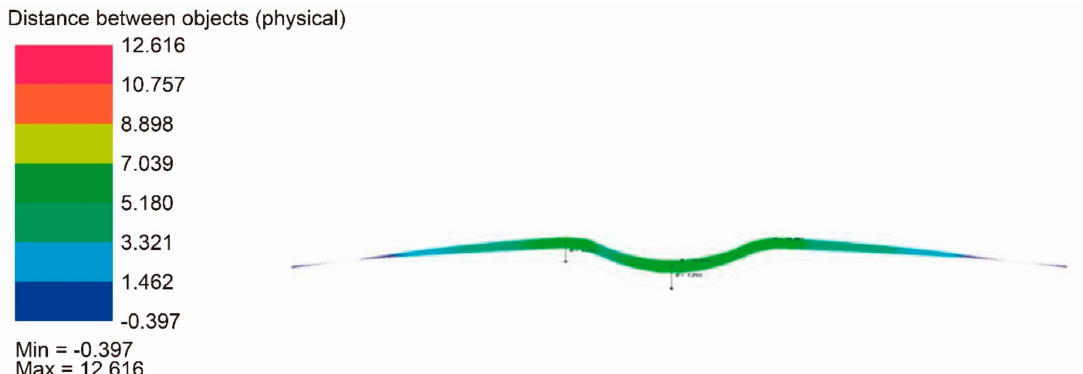
Figure 5. Simulation of the maximum distance to the block in the stamping area.